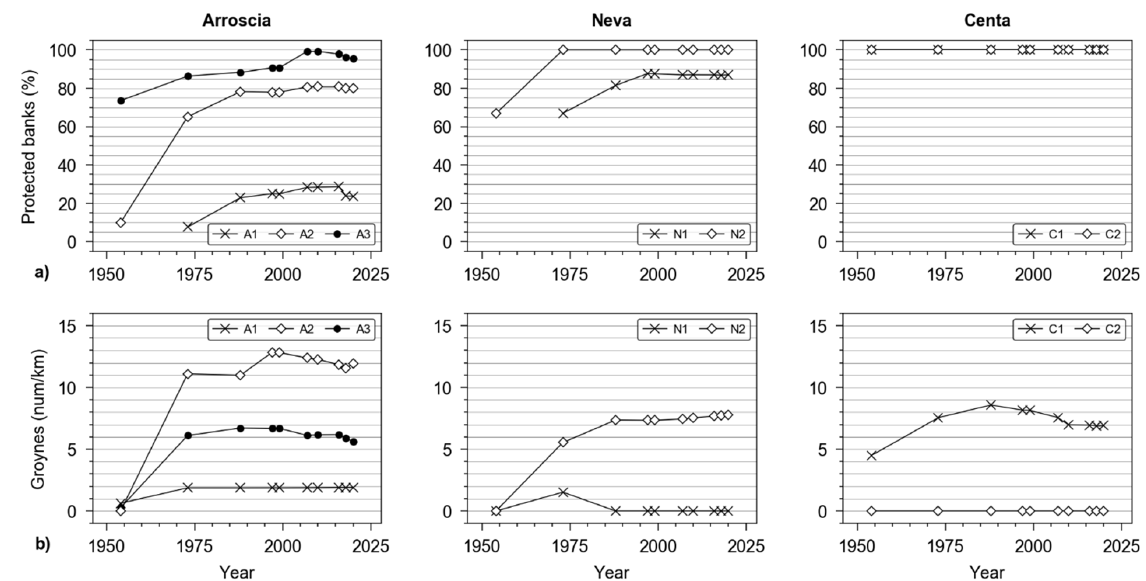
Figure 9. ( a ) Longitudinal bank protection extent and ( b ) groyne density over time at the reach scale. The lack of data referring to the 1954 longitudinal bank protection extent in reaches A1 and N1 is associated with the impossibility of mapping them with a certain degree of accuracy.